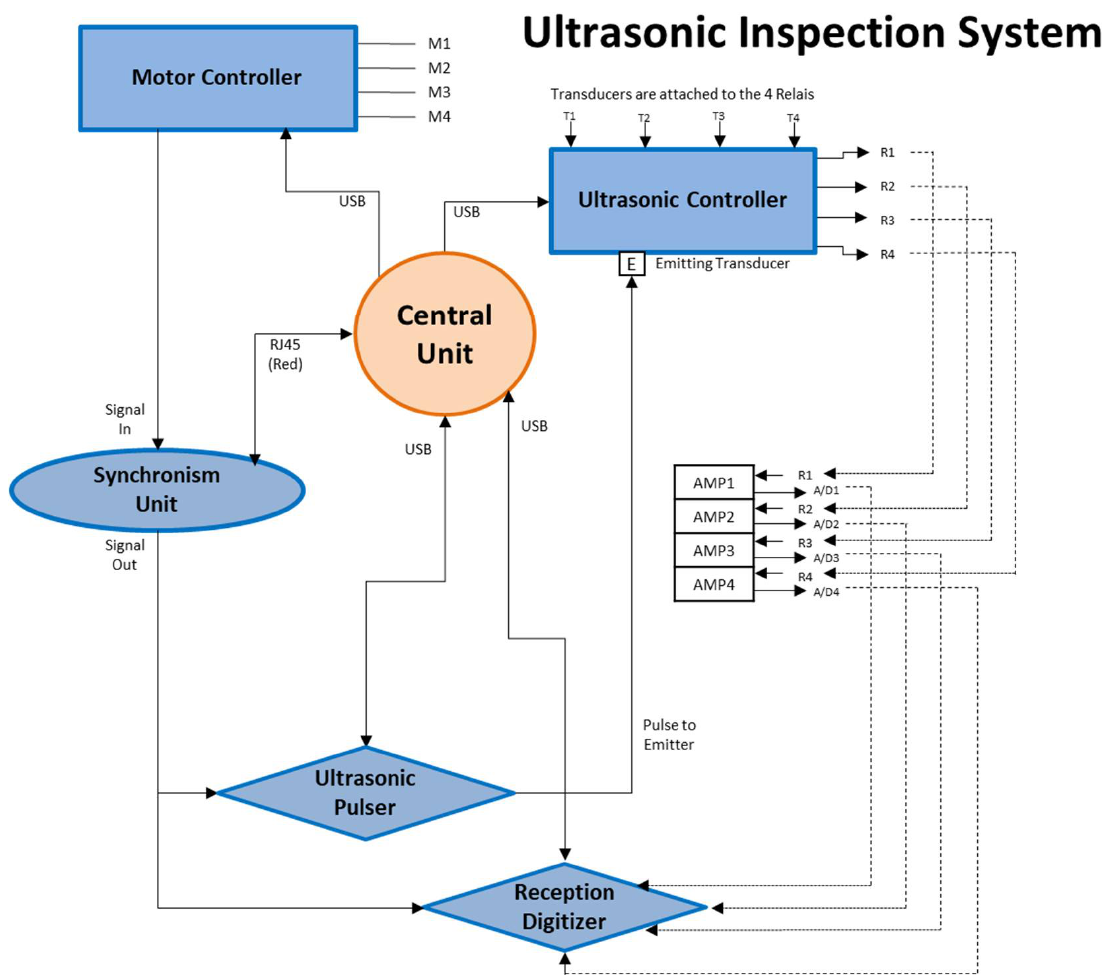
Figure 13. Schematic diagram of connections between the hardware of the ultrasonic inspection system [22].